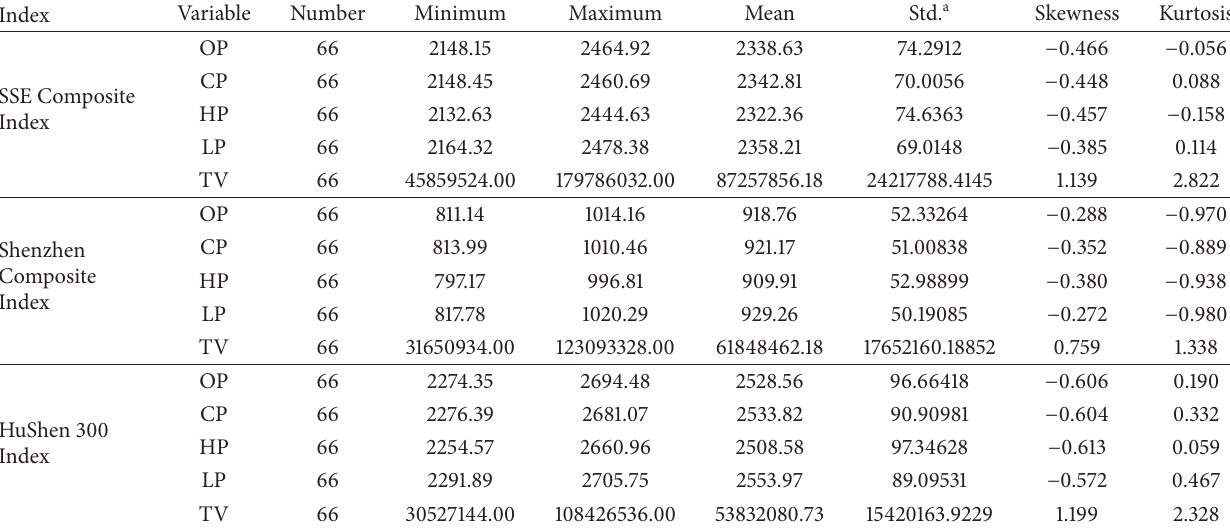
Table 1: Statistical characteristics of the three stock